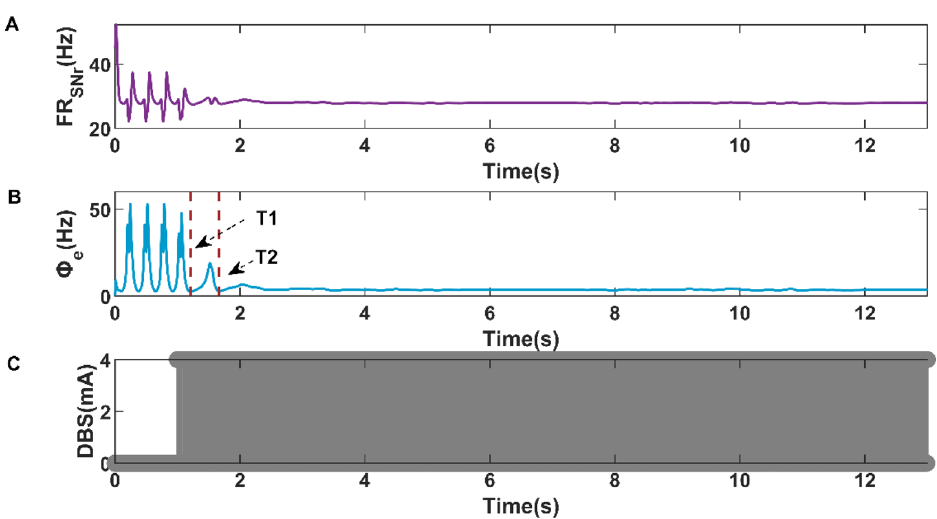
Figure 10. Variations of firing rate of SNr ( A ), firing activity of cerebral cortex ( B ), and the current of closed- loop DBS ( C ) during the closed-loop DBS control when the expected firing rate is 27.7884